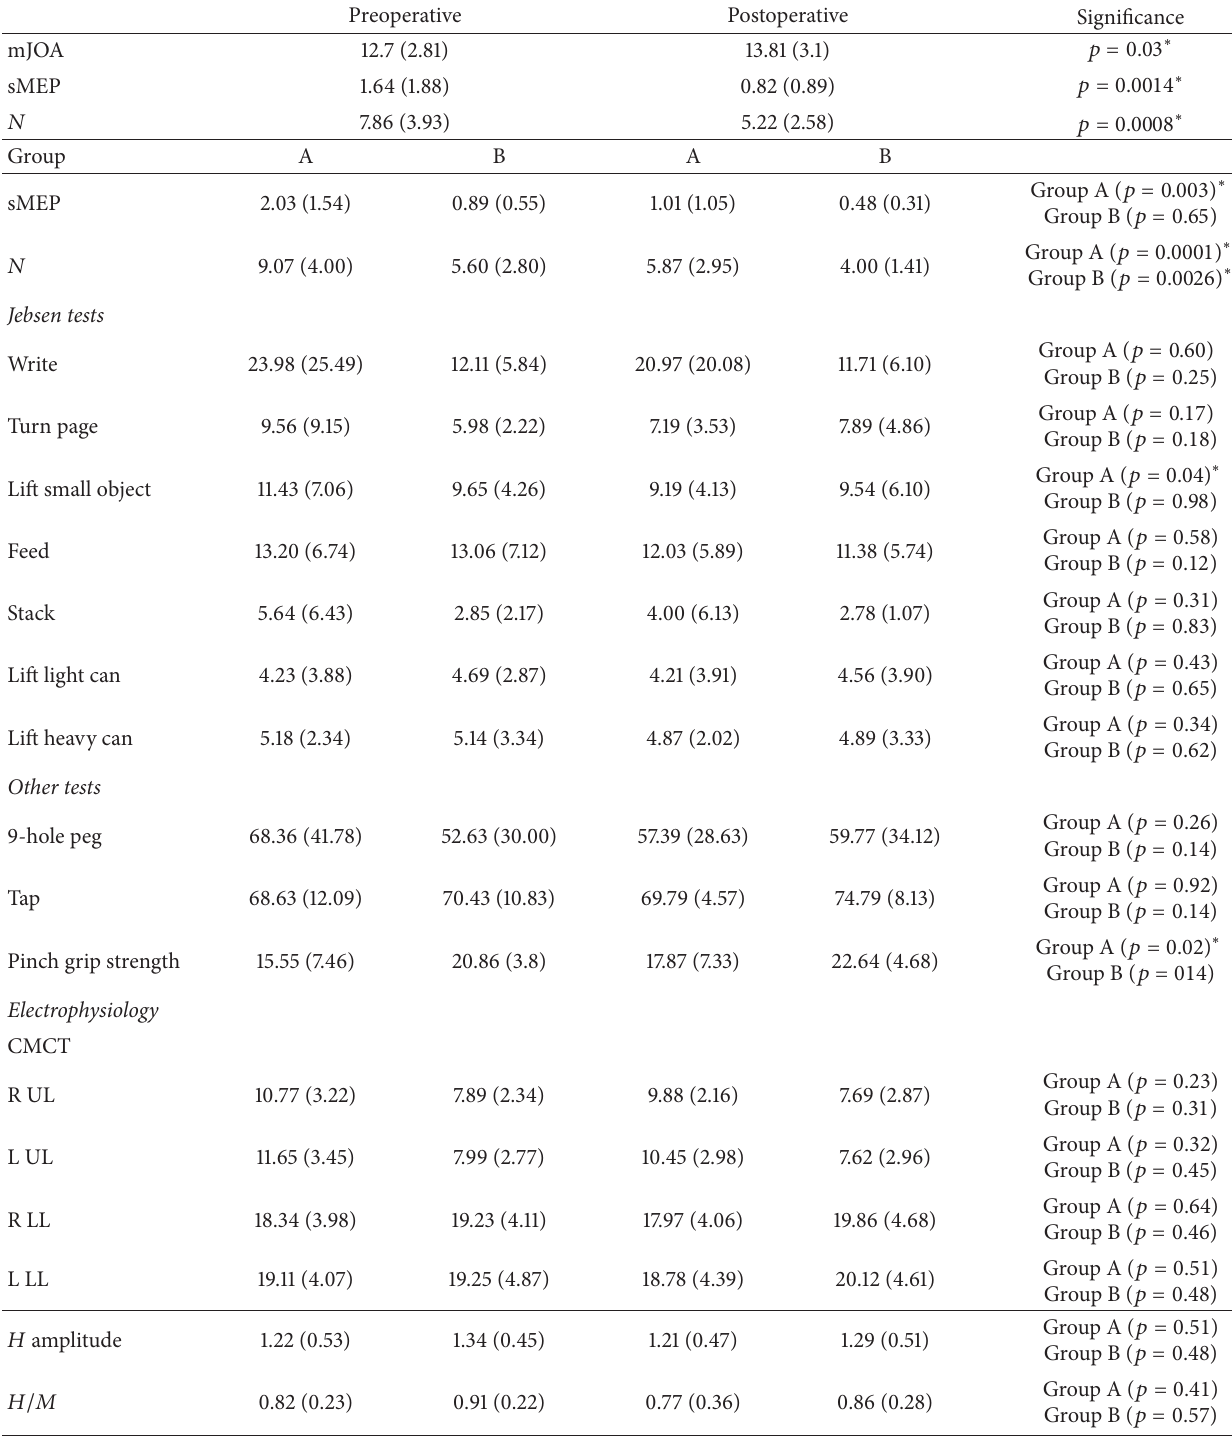
Table 1: Summary of experimental results in all